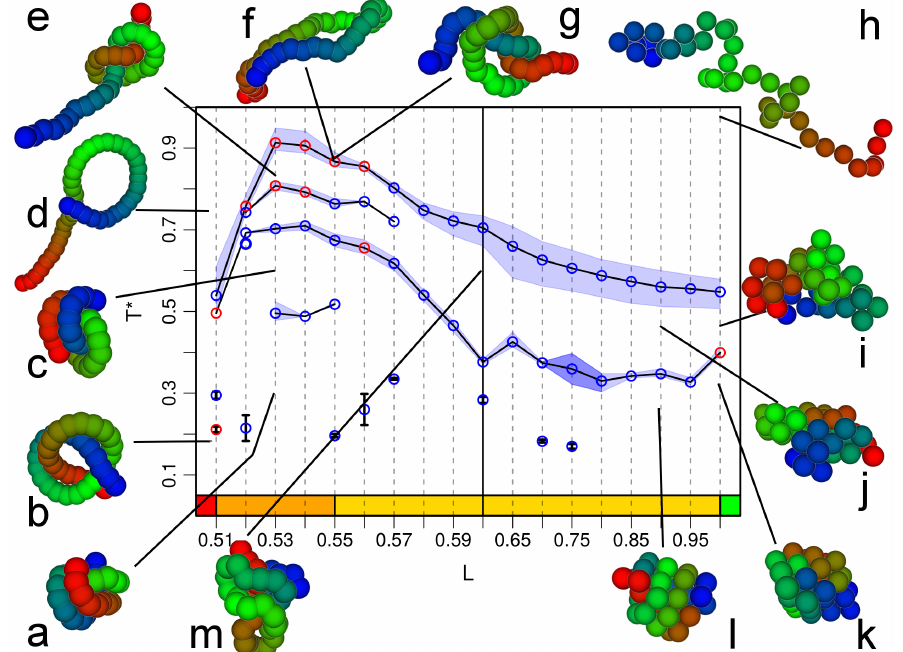
Figure 7. Pseudo phase diagram for chain length N = 40 including examples for configurations ( a – m ) which are the most probable in the different regions. Blue symbols are for second order transitions, and red symbols are for first order transitions. The shaded regimes indicate error estimates coming from different observables. Only points resulting from a signal in more than one observable are